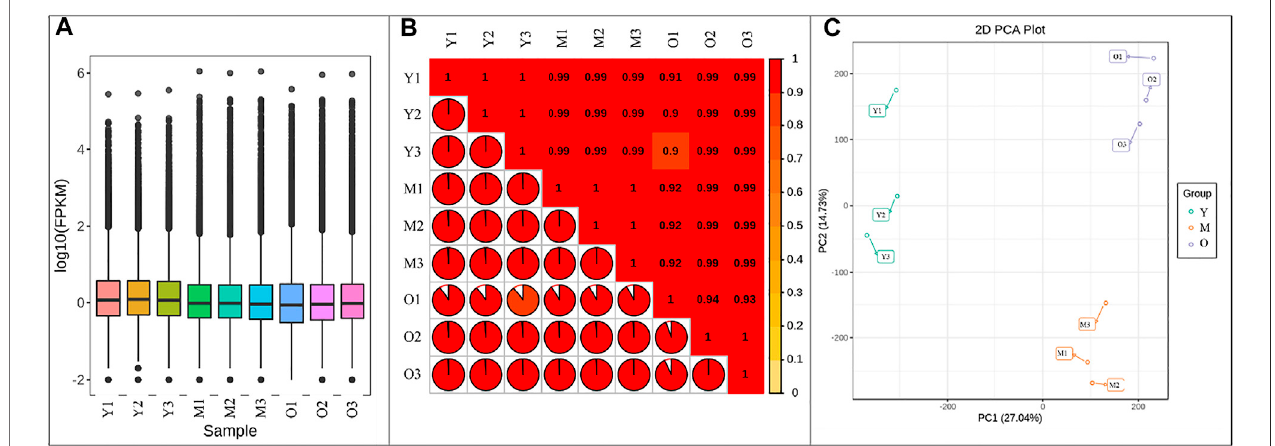
FIGURE 1 | (A) Overall distribution of gene expression in young (Y), mature (M), and old (O) ginger tissues. (B) Pearson ’ s Correlation Coef fi cient, and (C) Principal Component Analysis of the gene expression in ginger tissues. 1, 2, and 3 with the sample names represent the replicates.